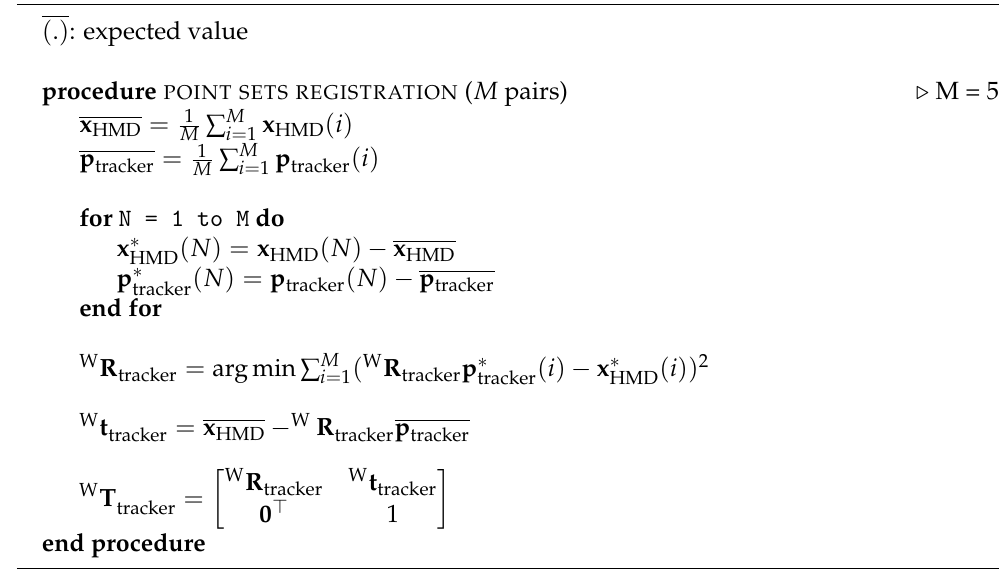
Figure 1. The calibration transformation chain. Transformations, shown as solid line arrows, are directly estimated, while transformations, shown as dash-line arrows, are derived. The blue color indicates the transformations in the HMD coordinate frame, and the orange color illustrates the transformations in the tracking system. The goal of tracking space to an HMD space calibration is to find the W T , shown in red. tracker Algorithm 1 Tracking Space to HMD Space